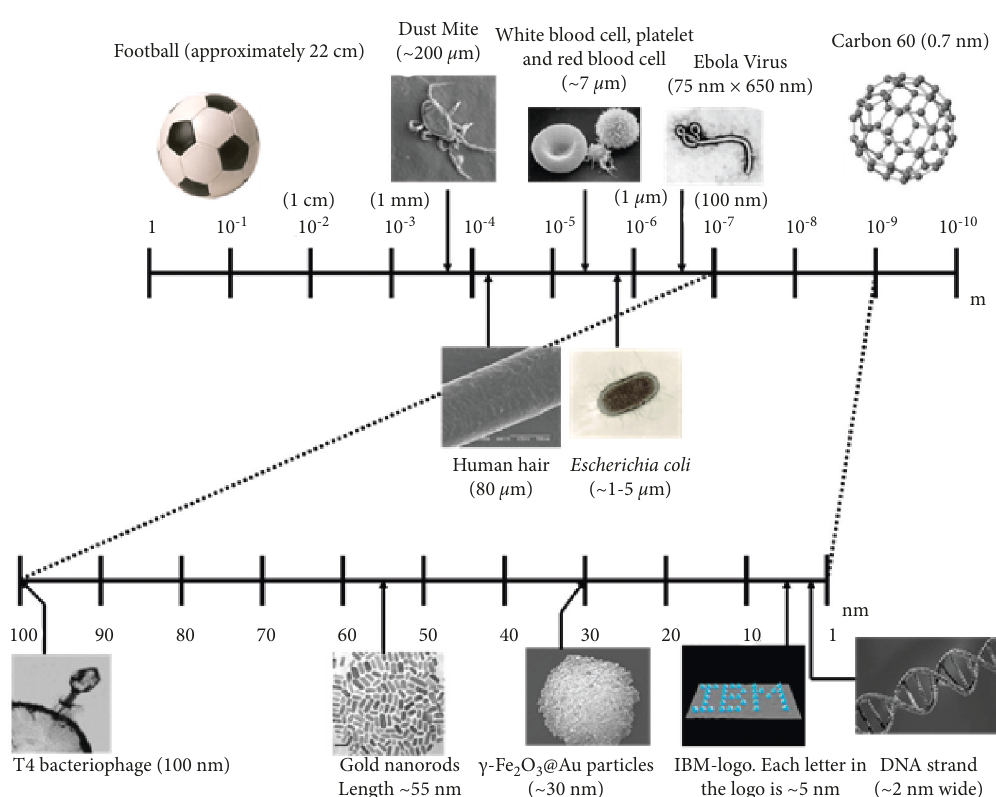
Figure 1: Picture showing the nanoscale in context. The length scale at the top ranges from 1 m to 10 − 10 m. The section from 10 − 7 m (100nm) to 10 − 9 m (1nm) is expanded on the length scale beneath. The typical length scale of interest for nanoscience is from 100nm down to the atomic